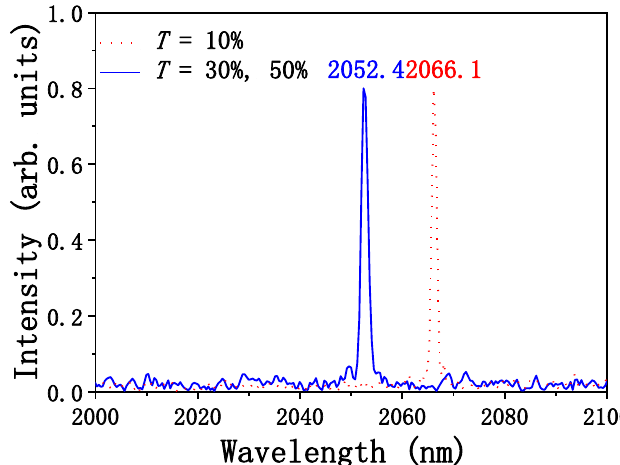
Figure 4. Output spectrum of the Ho:YVO 4 laser.